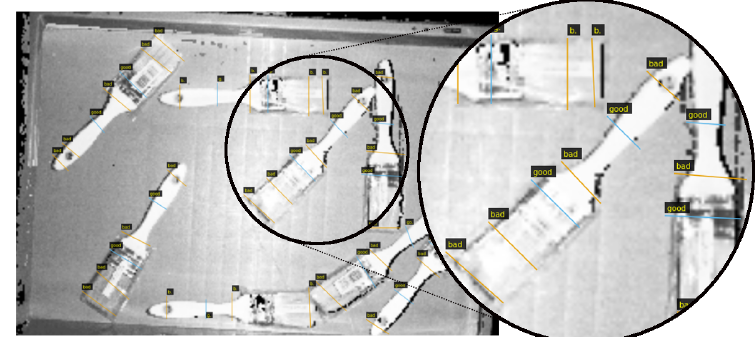
Figure 7. Gripper annotations in a RGB-D orthographic